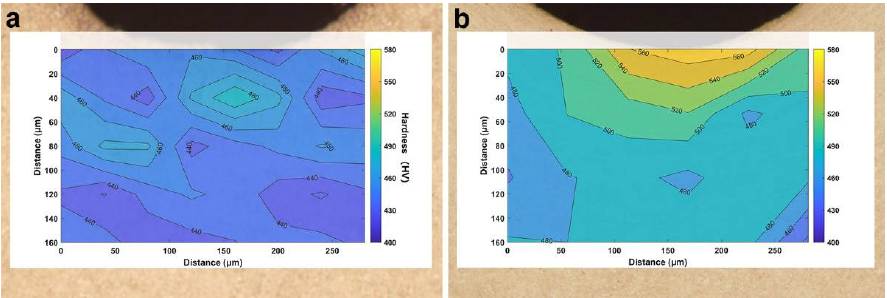
Figure 6. Contour map of the hardness beneath the thread: ( a ) as-received bolt and ( b ) rolled bolt.